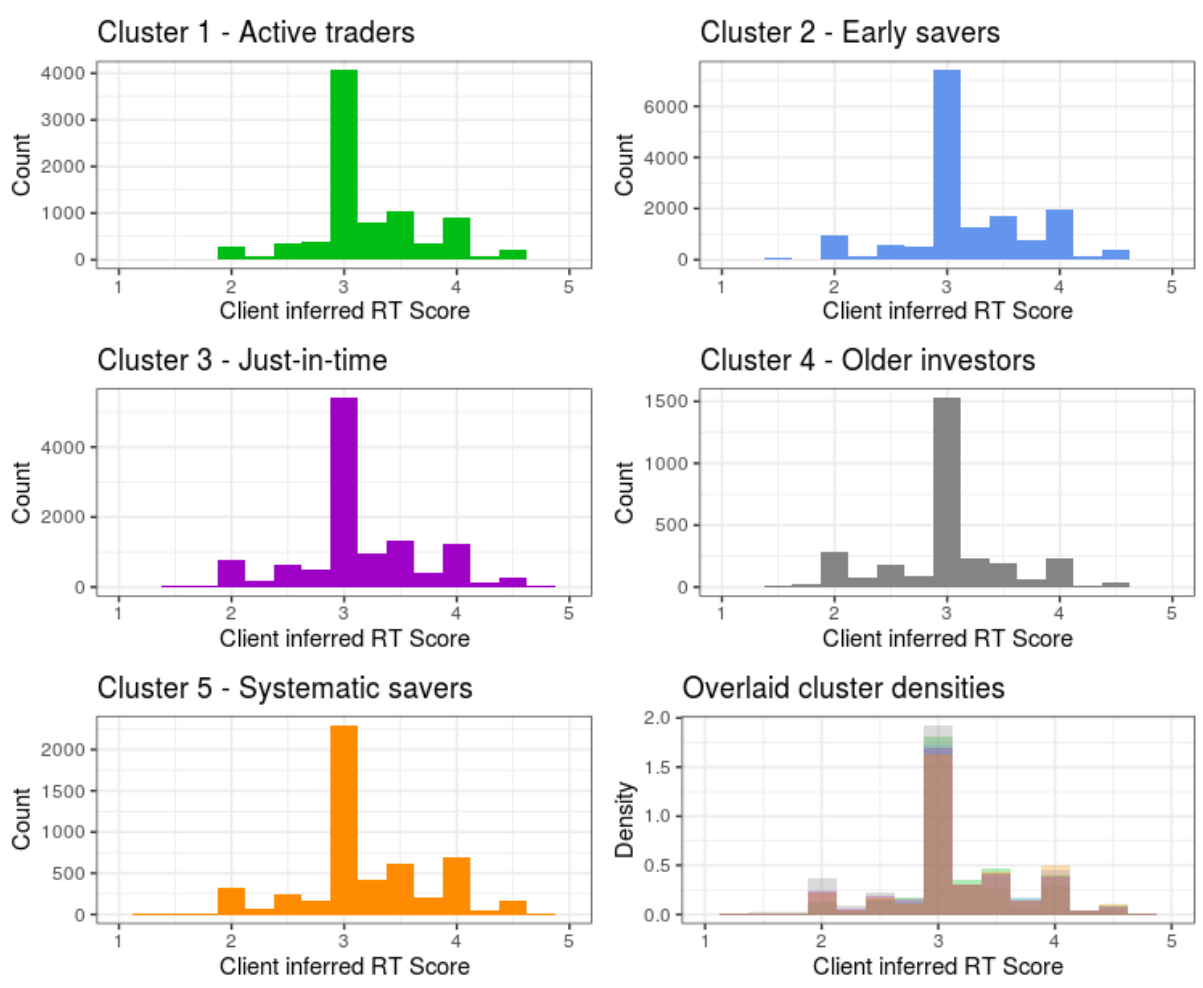
Figure 9. KYC-Inferred RT score distributions by cluster. The top four and bottom left panels are each cluster’s distribution by inferred RT scores. The bottom right panel is an overlay of the clusters’ RT score